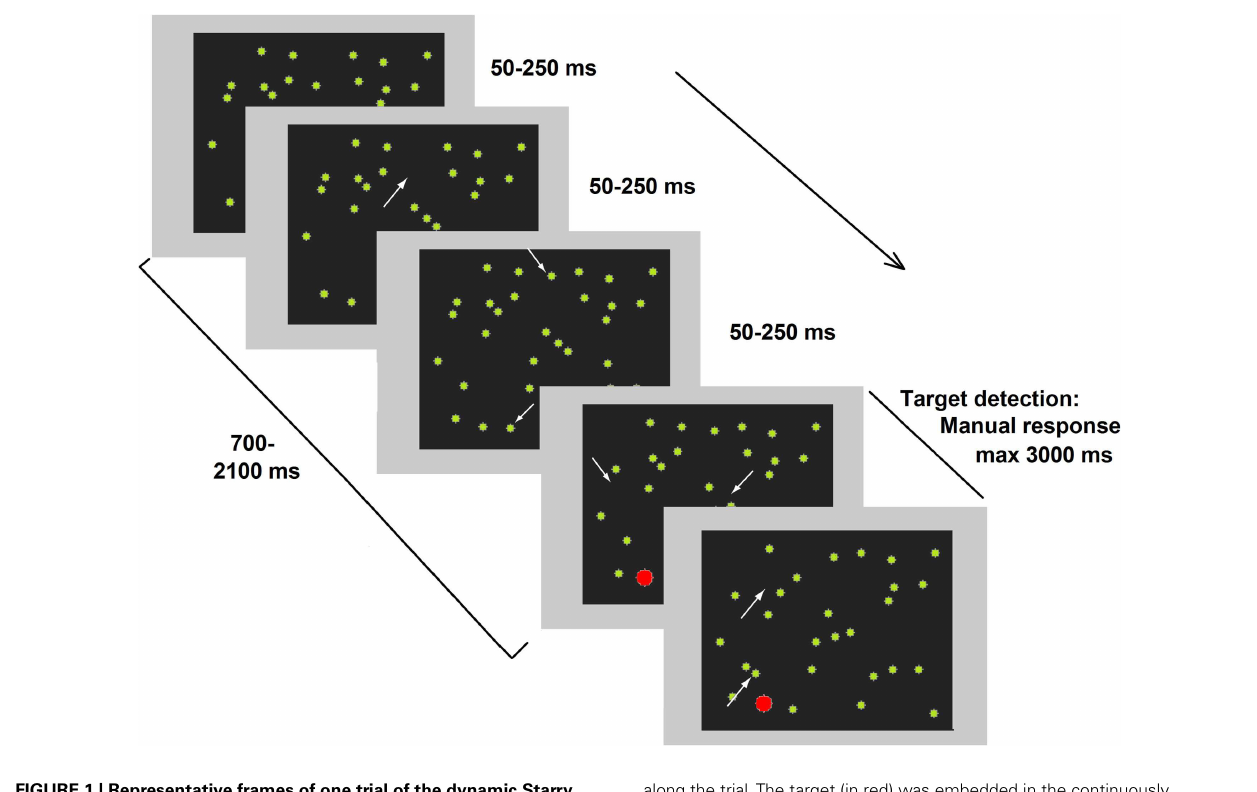
FIGURE 1 | Representative frames of one trial of the dynamic Starry NightTest (SNT). White arrows (not present in the real test) point to spatial positions where a distracter (green dot) appeared or disappeared